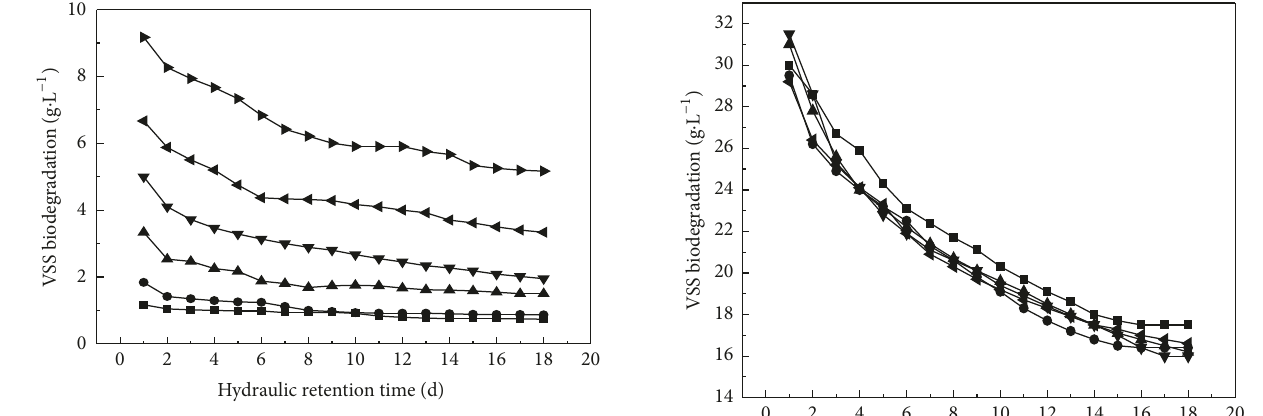
Figure 2: Effect of concentration on VSS removal. Concentra- tion/g ⋅ L −1 : ◼ 7; e 11; 󳵳 20; 󳶃 30; 󳶣 40; 󳶳 50.